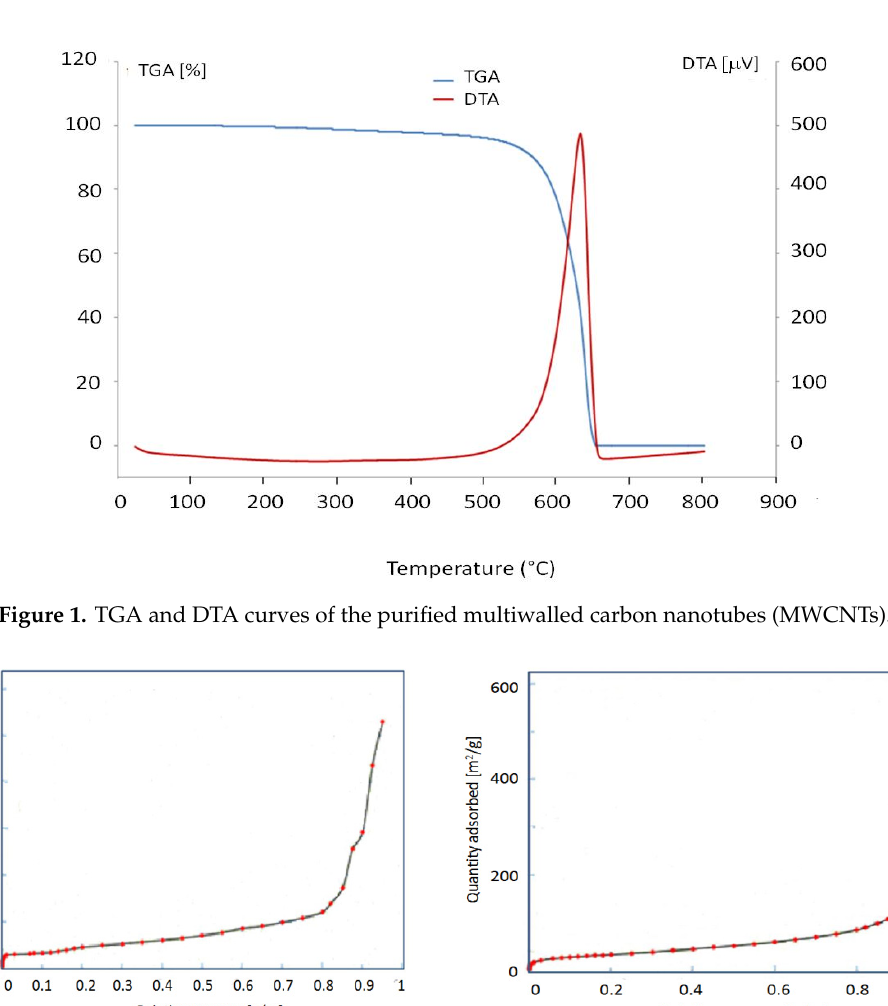
Figure 1. TGA and DTA curves of the purified multiwalled carbon nanotubes (MWCNTs).